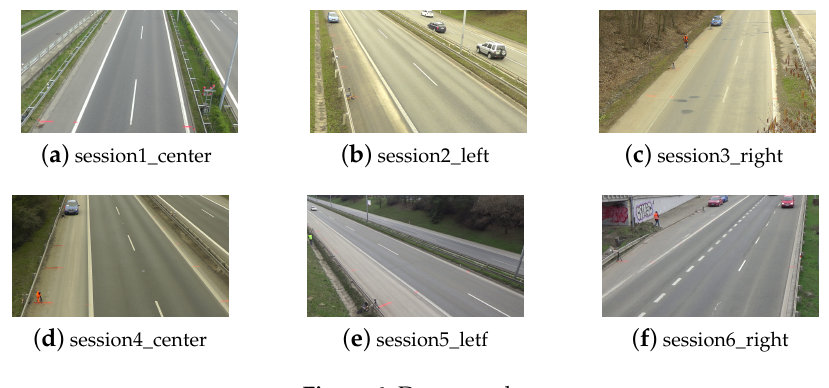
Figure 6. Data sample.